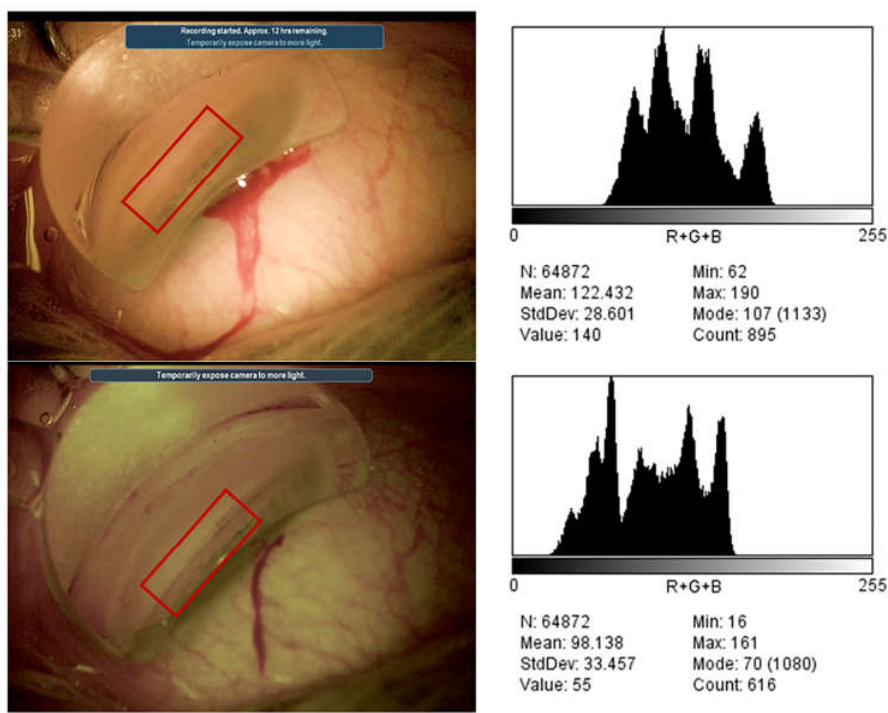
Figure 1. Standard-color images and images obtained with optimized digital settings during surgical gonioscopy and their luminance histograms in pixel values, generated with image J software. The contrast of the region of interest, represented as the difference in the standard deviation (DSD) of pixel intensity values, was 28.601 for standard colors and 33.457 for optimized digital settings. Very high levels of agreement were observed between the two surgeons (O.S. and